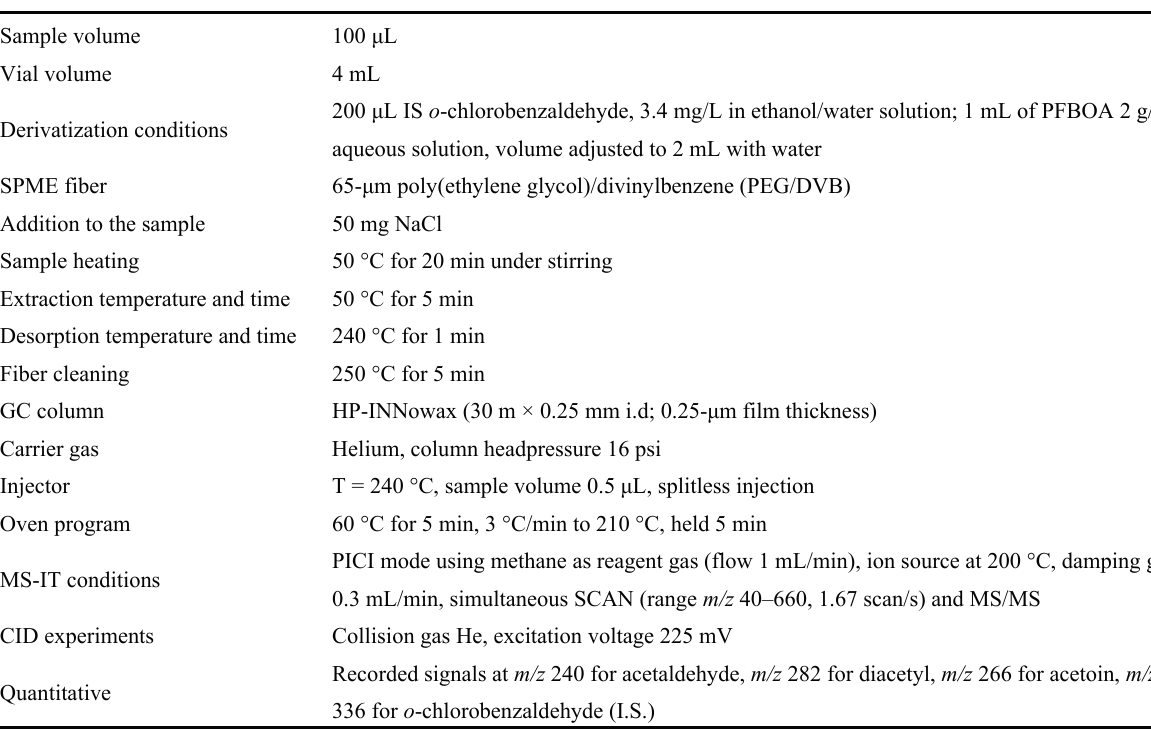
Table 2. Experimental conditions used for PFBOA derivatization and SPME-GC/MS analysis (ion trap and positive chemical ionization) of the main wine carbonyl compounds. Adapted from Flamini et al. , 2005